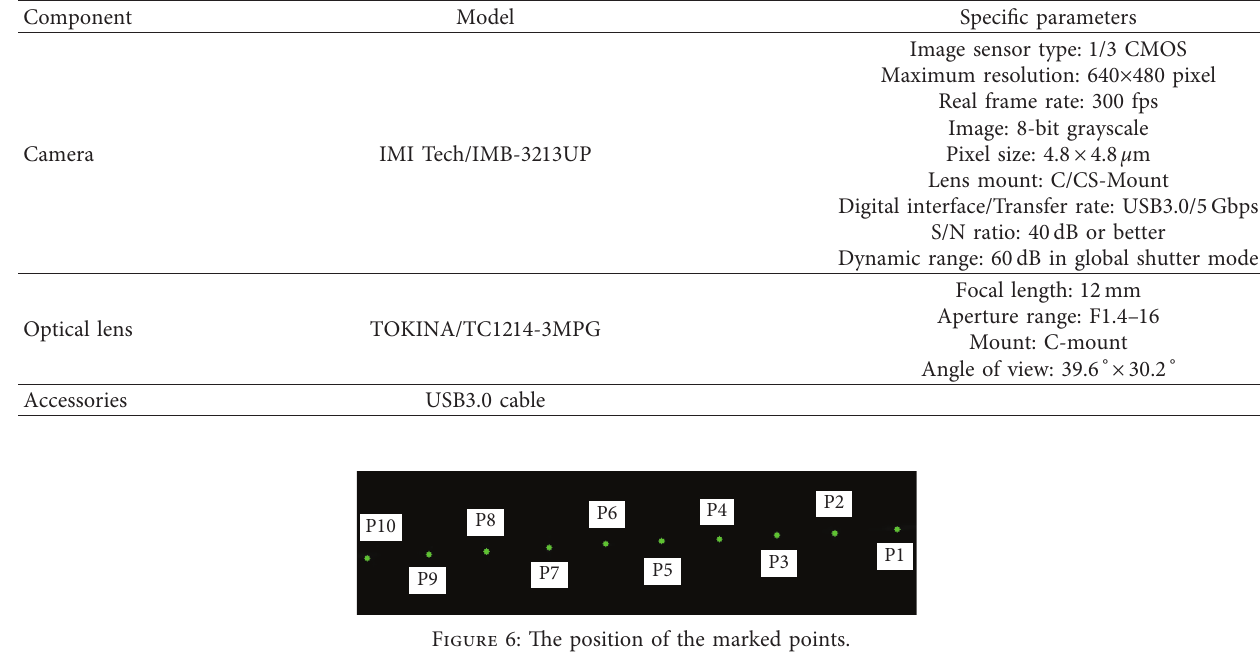
Table 1: Specific parameters of vision-measurement system.